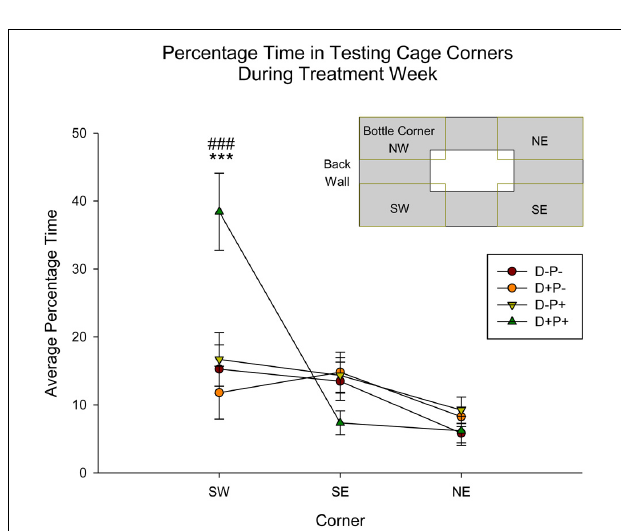
FIGURE 9 | Percentage time in specific testing cage corners during treatment week. The D+P+ group spent significantly more time in the SW corner of the testing cage relative to all other groups, as well as relative to the SE and NE corners. ∗∗∗ p < 0.001 (Relative to all groups); ### p < 0.001 (Relative to SE and NE corner). Data is expressed as mean ± SEM. Inset: Cage and corner